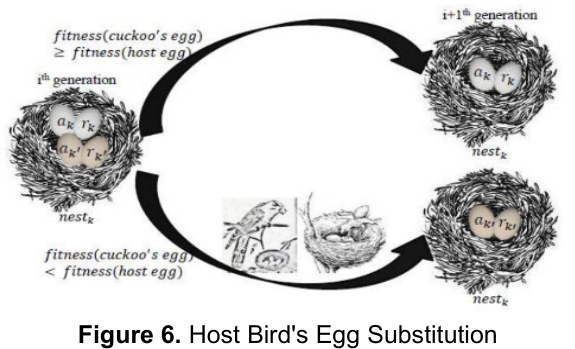
Figure 6. Host Bird's Egg Substitution